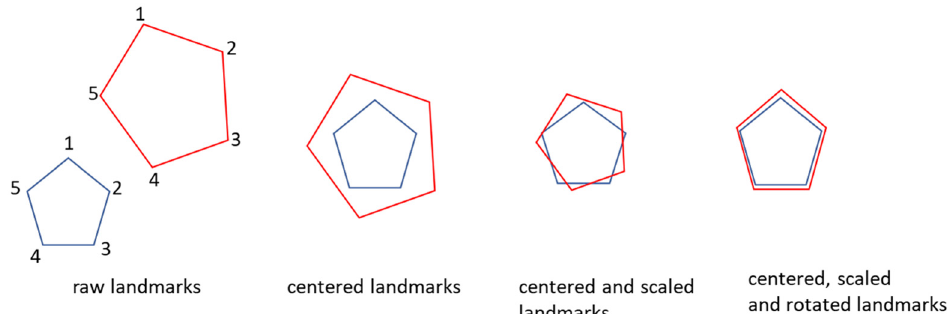
Figure 3. Process of Procrustes superimposition, modified and adapted from Mitteroecker and Gunz [39]. 2009, Mitteroecker and Gunz. This proceeds by standardising the size, position, and orientation of the landmark configurations through registration. Squared distances between equivalent landmarks obtained from all specimens are minimised by centering (translating), scaling, and rotating (aligning) the individual’s landmark configurations using their centroid (the arithmetic mean of all landmark coordinates). Scaling is carried out in order that the centroid size (CS or Csize—the square root of the sum of squared distances of a set of landmarks from their centroid) of each configuration is scaled to 1 by dividing the raw landmarks by their centroid size. Configurations are then superimposed at their centroids and iteratively rotated with respect to each other to minimize the sum of squared distances of the specimens from the mean shape. In the first iteration, the specimens are aligned to an arbitrarily chosen one and once all configurations are fitted to this, the rotation minimises distances between equivalent landmarks. Once all specimens are fitted, the sample mean of each coordinate is computed. In subsequent iterations, the configurations are fitted to the mean, which is recomputed and used in the next iteration. The algorithm stops when the sum of residuals from the mean reaches a minimum, usually after 3–5 iterations. The resulting registered landmark coordinates are known as “shape coordinates” and can be submitted to statistical analysis.